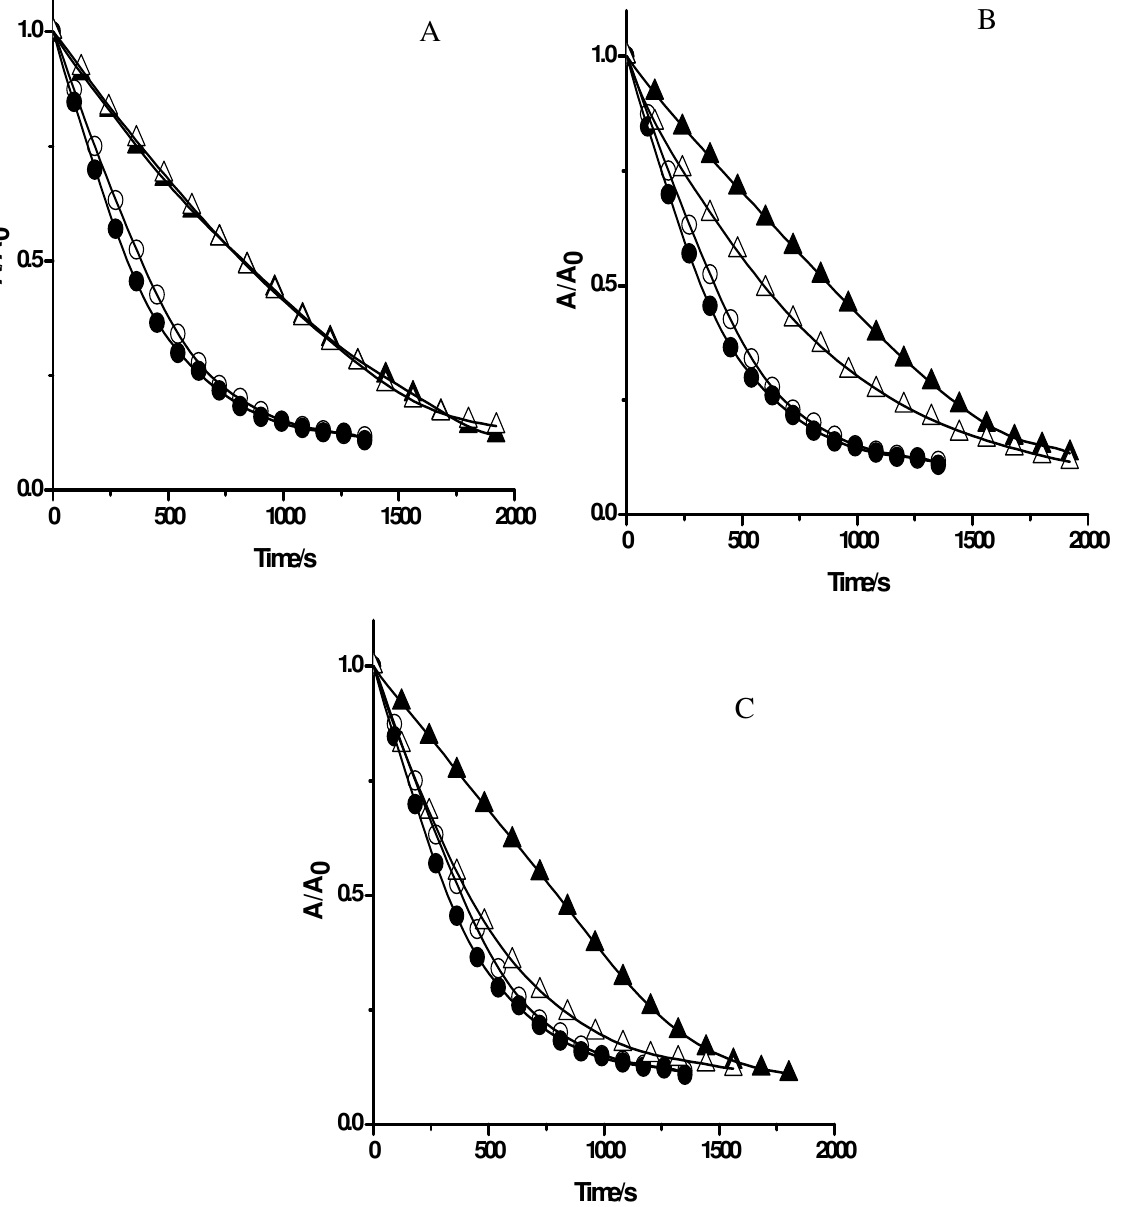
Figure 4. Effect of gallate derivatives ( A gallic acid; B propyl gallate; C octyl gallate) on the consumption of PGR induced by AAPH derived peroxyl radicals in the absence and presence of Triton X-100 micelles. PGR (5 µM) was incubated with AAPH (10 mM) and the gallate derivatives (at 5 µM) in micellar ( (cid:1) ) and phosphate solutions ( (cid:2) ). Control experiments without gallate derivatives were carried out in the presence ( (cid:1) ) and absence ( (cid:1) ) of Triton X-100